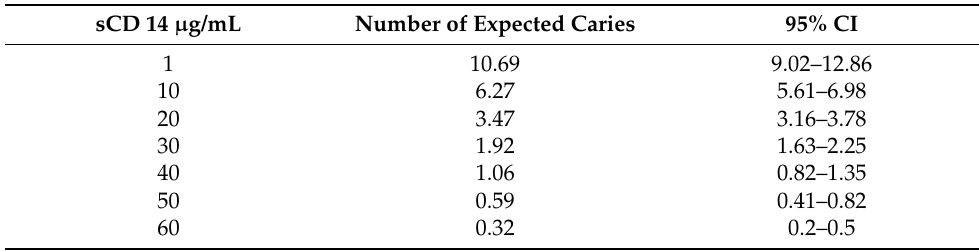
Table 5. Expected numbers of decayed teeth with 95% CIs for the same selected values of sCD14 in µ g/mL in the case where the probability hurdle is